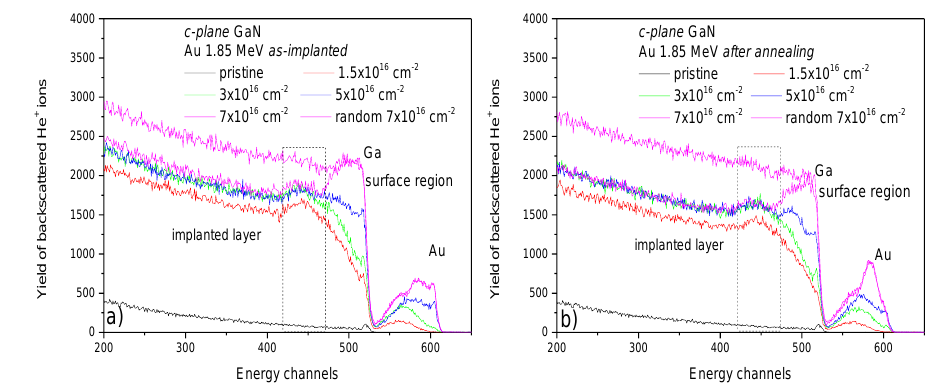
Fig. 1. RBS-C spectra of GaN pristine as well as the samples implanted with Au ions with energy 1.85 MeV in a), and corresponding samples after 20 minutes of annealing at 800 °C in ammonia atmosphere in